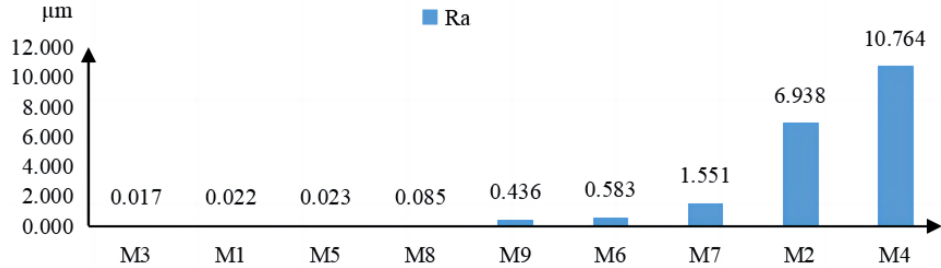
Figure 7. Material surface roughness (M1: Joinery board, M2: PVC board, M3: Fireproof board, M4: Solid wood board, M5: Painted solid wood board, M6: Melamine board, M7: Painted board, M8: Blister board, M9: Quartz board).